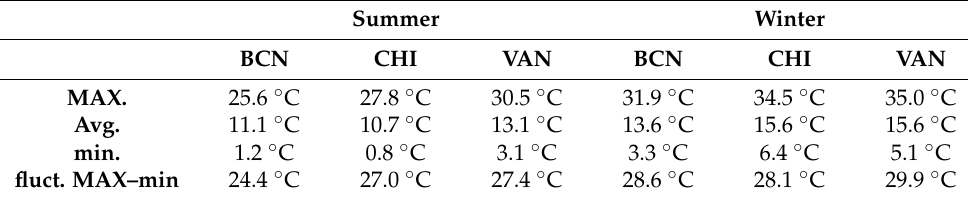
Figure 15. Temperature of the louvres on each summer day calculated.